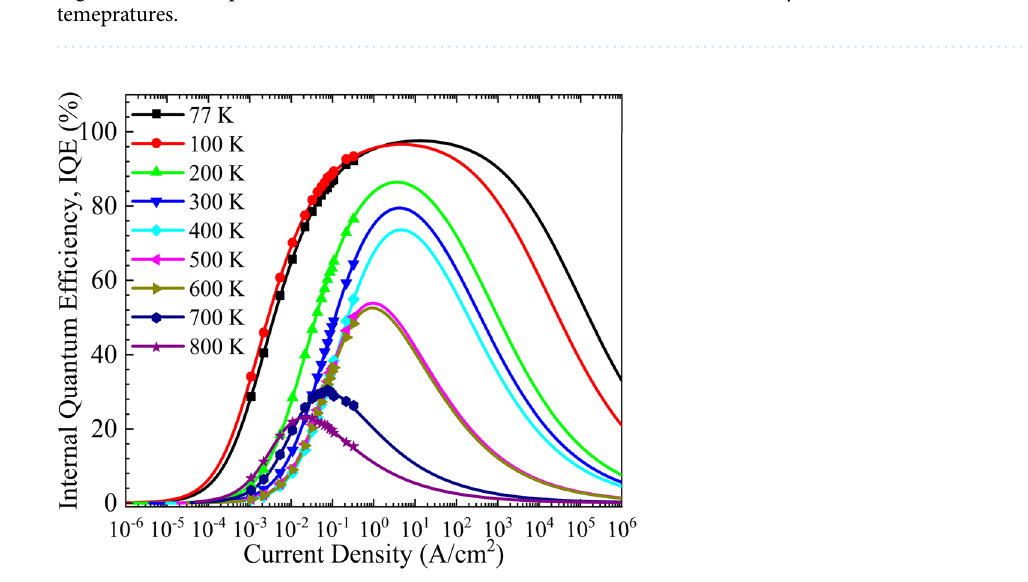
Figure 3. Internal quantum efficiency is plotted as a function of current density at different